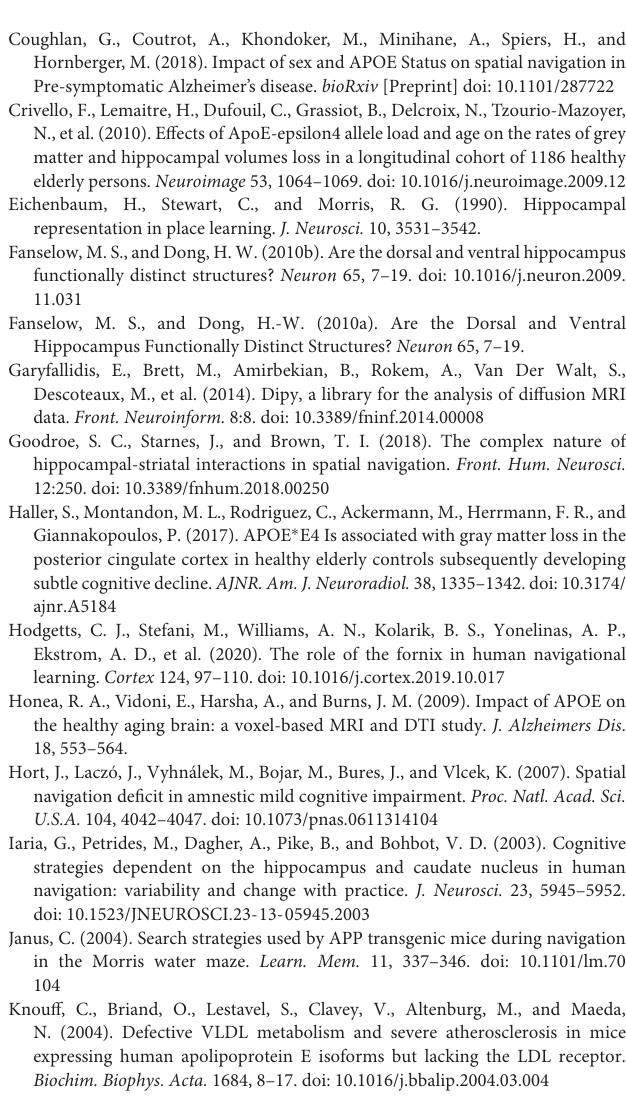
Supplementary Figure 1 | Violin plots for the probe trials 1 h after ending the learning trials. Violin plots show median, interquartile (box), lower and upper adjacent data values, kernel probability density for the data. Supplementary Figure 2 | Probe trials 3 days after ending the learning trials. Violin plots show median, interquartile (box), lower and upper adjacent data values, kernel probability density for the data. Supplementary Figure 3 | Violin plots for imaging and network markers for volume, FA, degree of connectivity and clustering